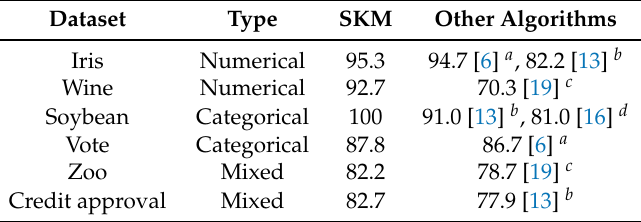
Table 8. Clustering accuracy (in percent) of the real